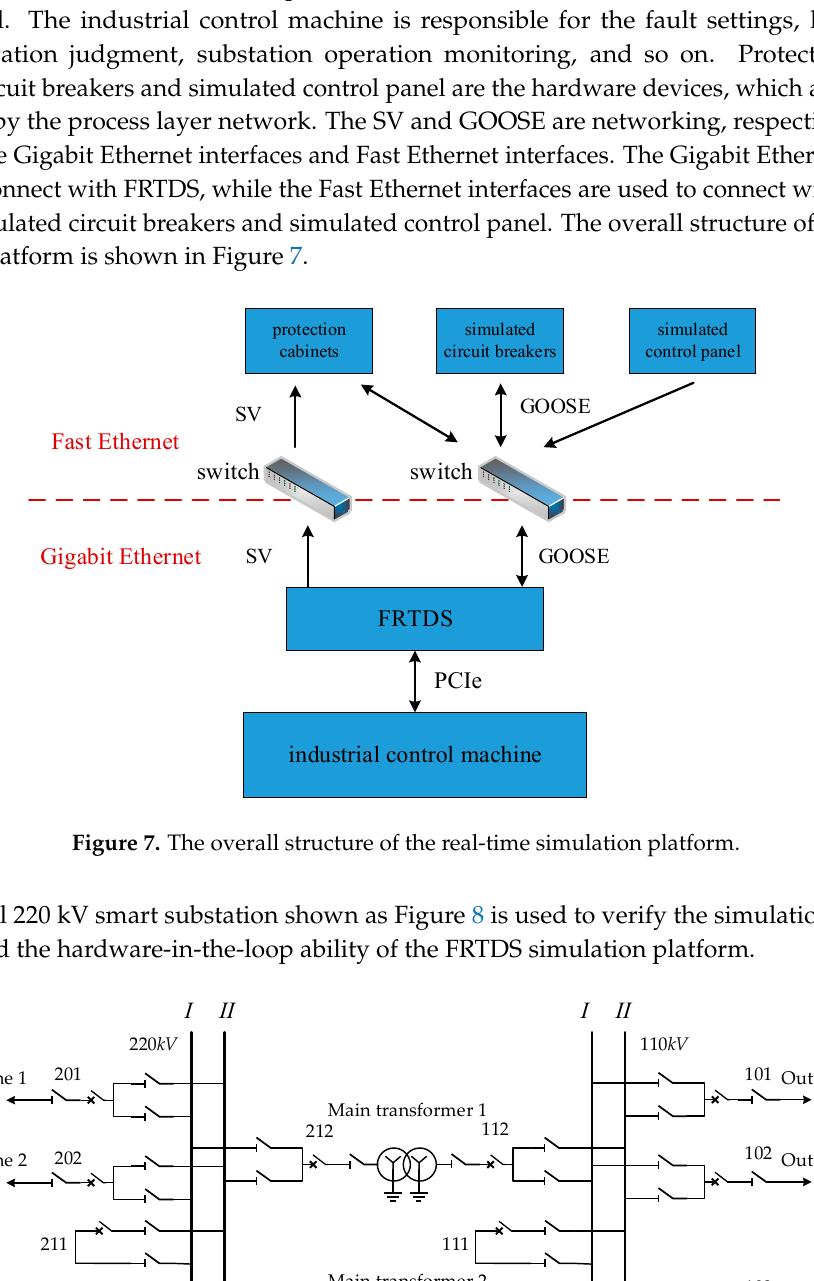
Figure 8. Main wiring diagram of 220 kV smart substation.